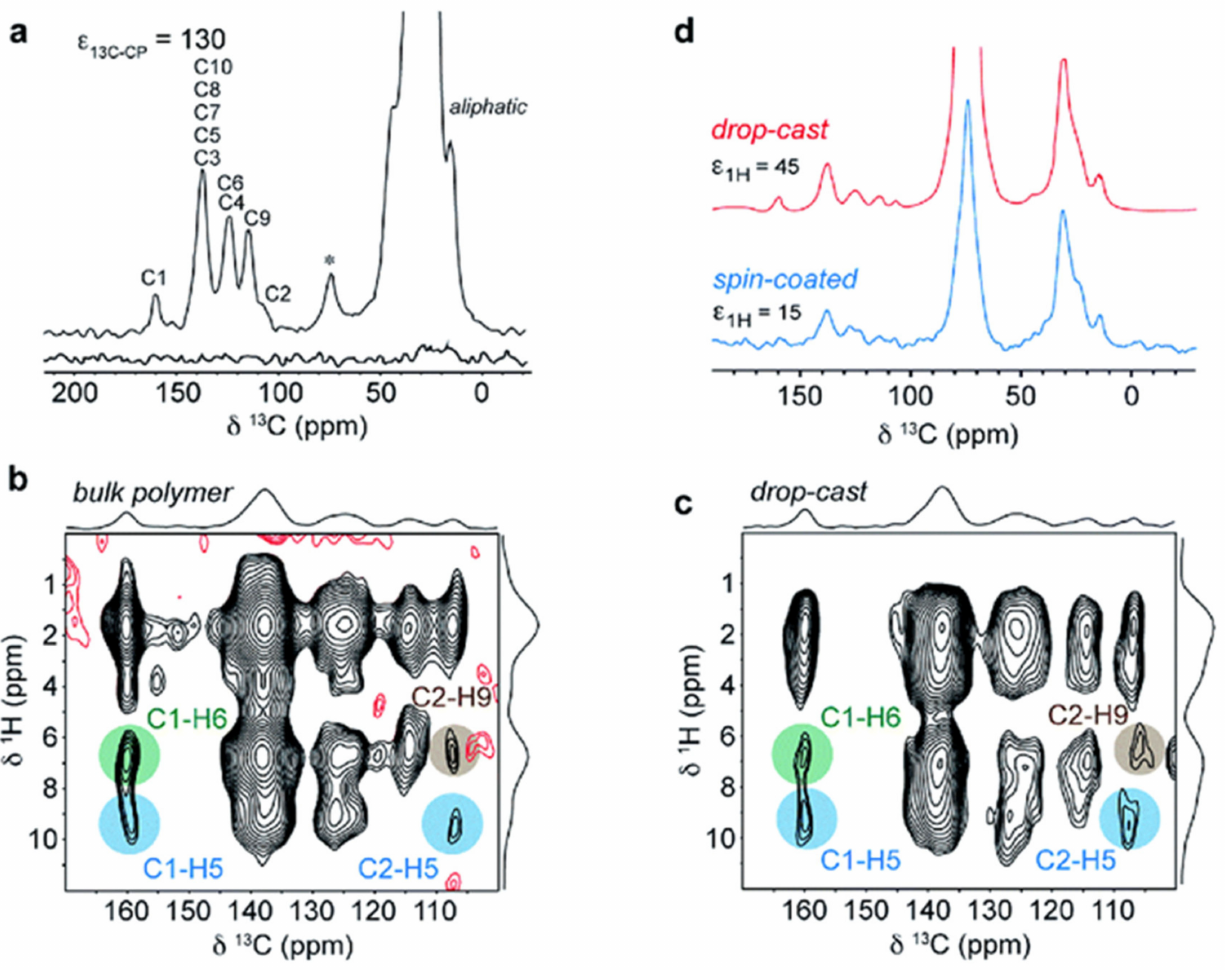
Figure 4. ( a ) 13 C DNP-CPMAS NMR spectra for DPP-DTT bulk polymer with (upper spectrum) and without (lower spectrum) DNP enhancement. ( b ) 1 H- 13 C DNP-HETCOR NMR spectra for DPP-DTT bulk polymer. ( c ) 1 H- 13 C DNP- HETCOR NMR spectra for the drop-cast film. ( d ) 13 C DNP-CPMAS NMR spectra for DPP-DTT drop-cast (red) and spin-coated (blue) films. Reproduced with permission. [112] Copyright 2017, The Royal Society of